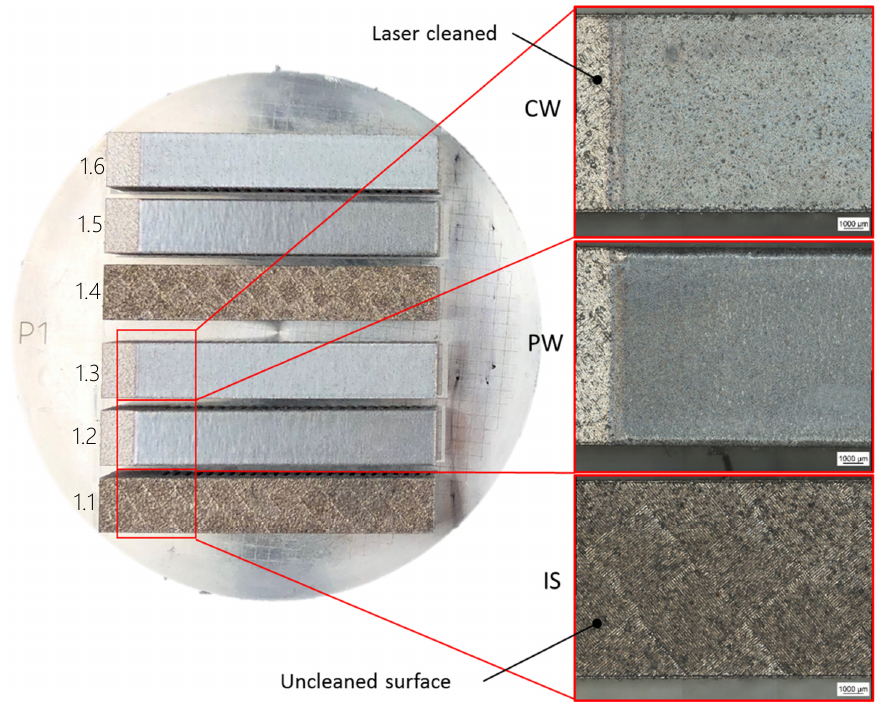
Figure 8. Built platform in the initial state (IS) and polished cantilevers with pulsed laser radiation (PW) and continuous laser radiation (CW).